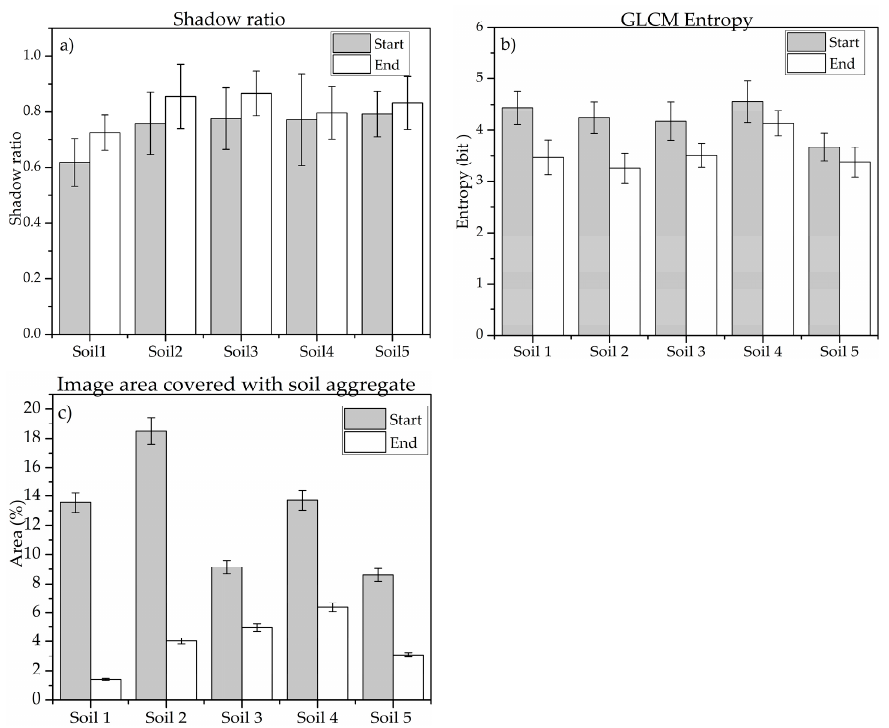
Figure 10. Summary results of shadow ratio, entropy and area covered with aggregates obtained for all soils using: band ratio (blue/red) ( a ); GLCM entropy ( b ); and Huang thresholding ( c ) approaches. The grey and white bars indicate the start and the end of the experiment, respectively. Each dataset is relative to each tray and cannot be taken as an absolute value.